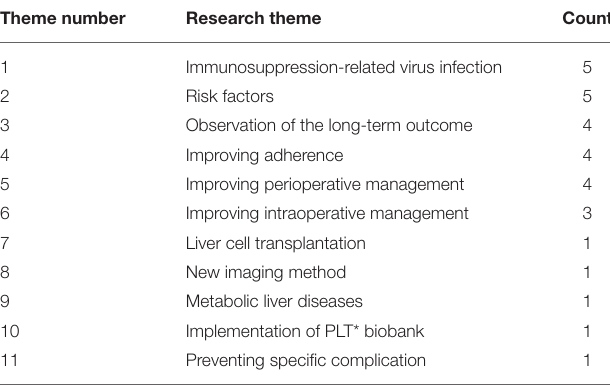
TABLE 1 | Clinical trials categorized by their research theme.